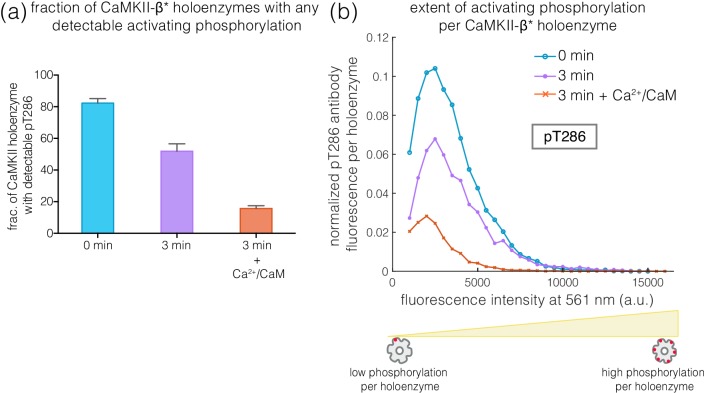
Effect of addition of Ca2+/CaM on the rates of dephosphorylation at the autonomy site.(a) Fraction of CaMKII-β* holoenzymes with detectable phosphorylation at Thr 286, upon 3 min of λ-phosphatase treatment in the absence and presence of 5 μM Ca2+/CaM. (b) Intensity distribution of pThr 286 (561 nm) for CaMKII-β* holoenzymes with detectable phosphorylation, under the same conditions as in (a) (see Materials and methods for details of normalization).